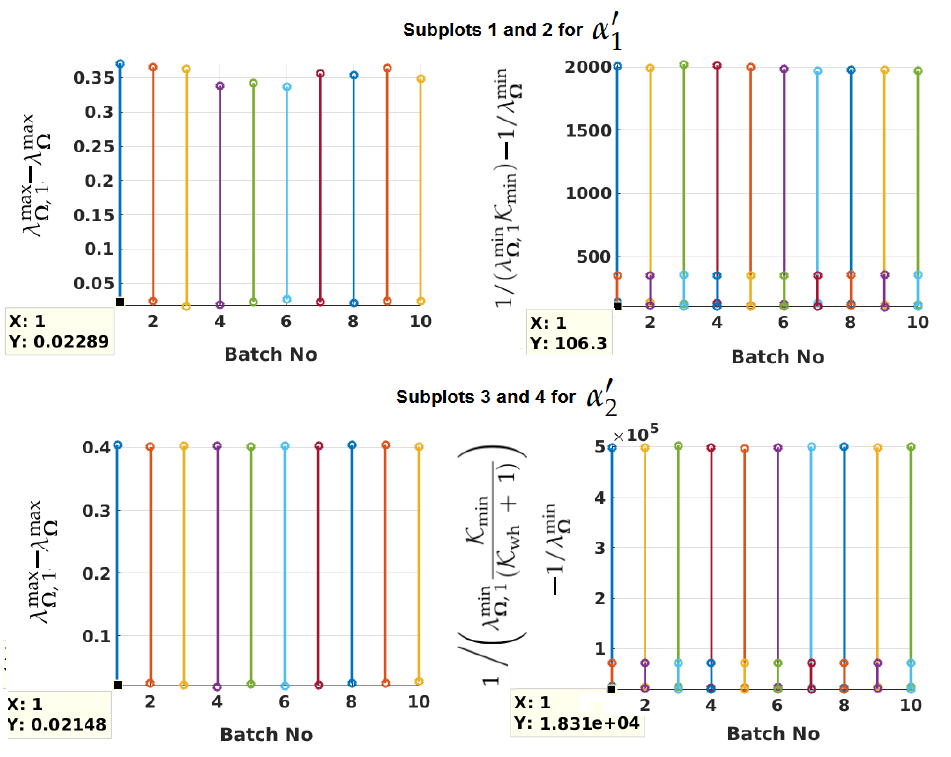
Figure 3. Differences between maximum (and minimum) eigenvalues of Ω 1 and Ω over five hundred thousand simulations for each α (cid:48) and α (cid:48) 1